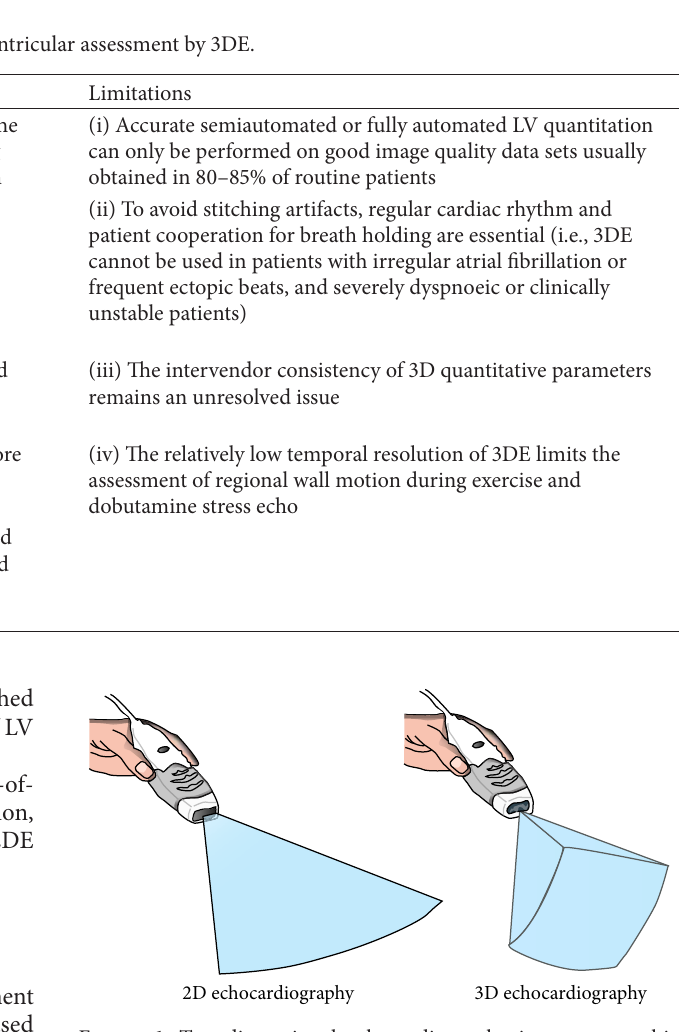
Figure 1: Two-dimensional echocardiography is a tomographic technique which provides “flat” views of the heart and great vessels whose thickness is fixed and related to the piezoelectric element vertical dimension. Three-dimensional echocardiography is based on real-time volumetric imaging that allows acquisition of pyramidal data